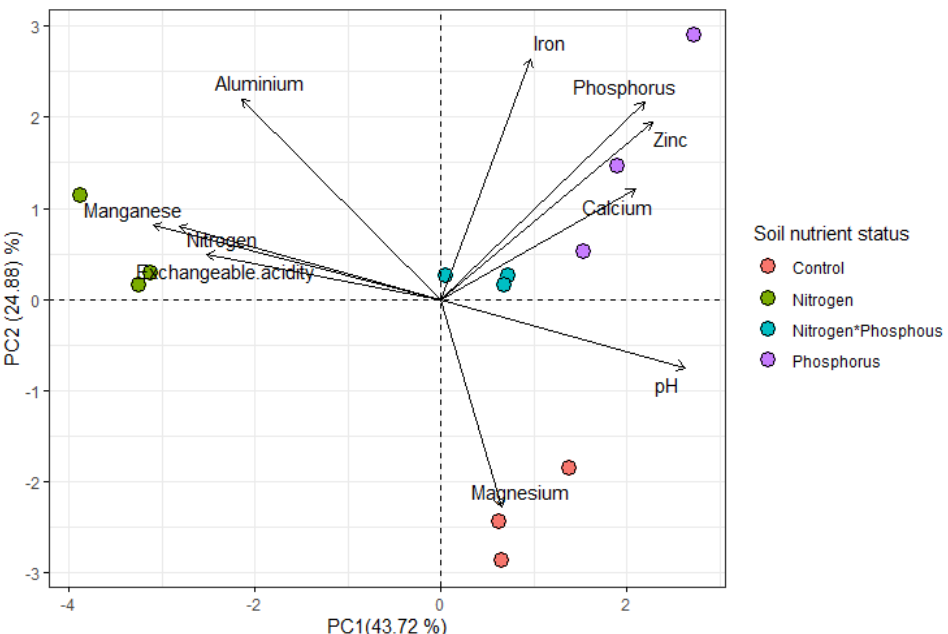
Figure 1. Principal component analysis (PCA) for all standardized soil chemical concentrations un‑ der four different soil nutrient status treatments: control (no nutrients), nitrogen (limestone ammo‑ nium nitrate), phosphorus only and both nitrogen (limestone ammonium nitrate) and phosphorus. The plot shows the relationship among the soil chemical variables. Positively correlated variables are grouped together, and negatively correlated variables are positioned on the opposite ends from the plot origin. The quality of the variables is assessed by the distance between the variable and the origin. The longer the length of the variables, the greater its level of contribution. Key: control (pink solid circle), N only (green solid circle), N and P (blue solid circle, P only (purple solid